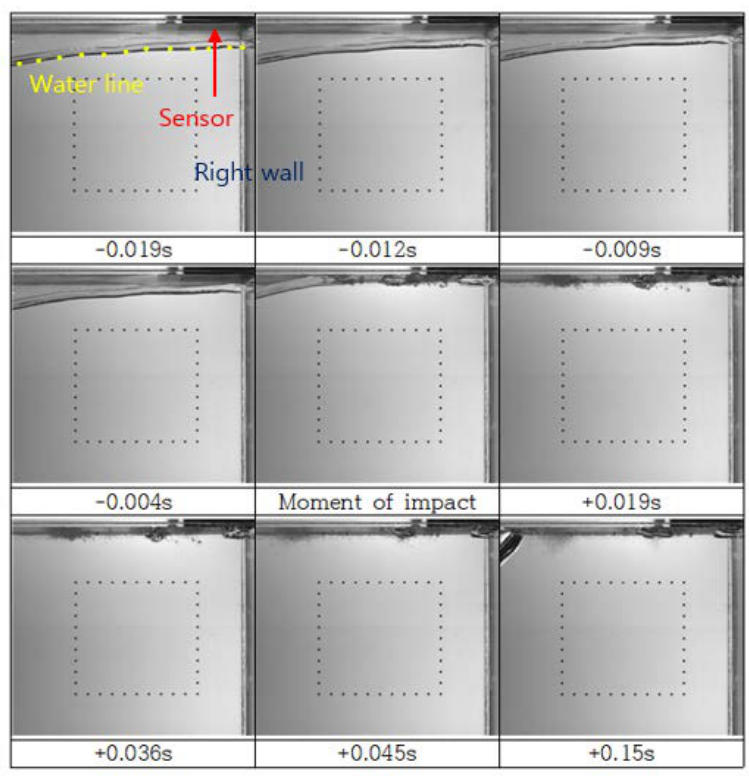
Figure 8. Snapshots of Flow: SWAY (Dry).